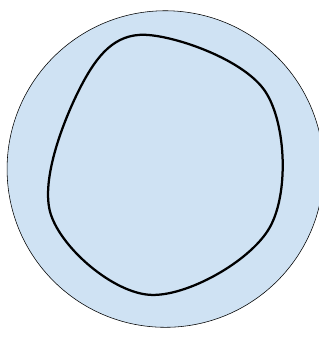
Figure 1 . Free Energy diagram with inverse temperature (cid:12)